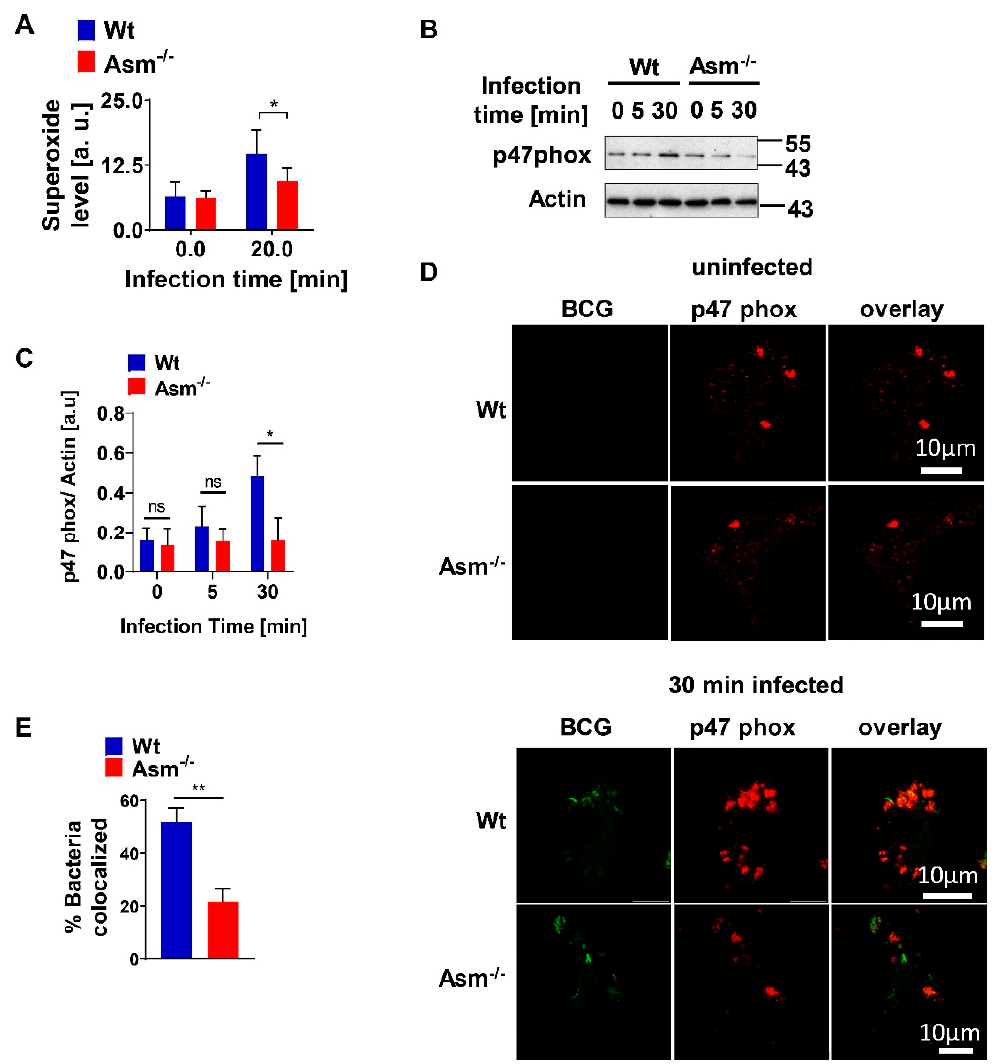
Figure 4. Acid sphingomyelinase controls ROS production upon BCG infection via nicotinamide adenine dinucleotide phosphate (NADPH) oxidase. Wild-type (Wt) and acid-sphingomyelinase- deficient (Asm − / − ) bone-marrow-derived macrophages (BMDMs) were infected with BCG for the indicated time. ( A ) Superoxide production was measured by electron spin resonance. Displayed is mean ± SD of 3 experiments; ANOVA and Bonferroni’s multiple comparisons test. ( B ) Expression of NADPH oxidase subunit p47 phox was determined by Western blotting of lysates obtained from BCG- infected or non-infected macrophages. ( C ) Expression of p47 phox was normalized to actin levels and displayed as arbitrary units (a.u.) by using ImageJ. Shown are means ± SD of 3 experiments; p-values were calculated by ANOVA followed by Bonferroni’s multiple comparisons test. ( D ) BMDMs were infected with GFP-BCG for 30 min, fixed, and stained with Cy3-labelled p47 phox antibodies, and samples were analyzed by confocal microscopy. Scale bar = 10 μ m. Picture represents at least 3 independent studies. ( E ) Percentage of GFP-expressing BCG that co-localized with p47 phox was measured from at least 50 bacteria/sample and presented as mean ± SD of 3 experiments. ** p < 0.01, * p < 0.05 (Student’s t -test). ns = no significant.